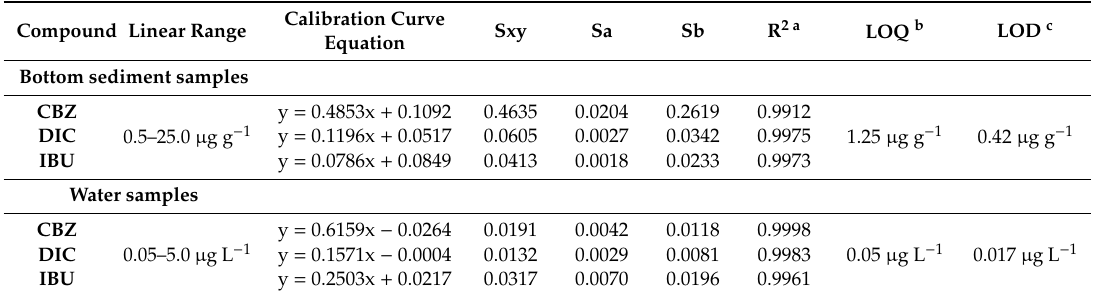
Table 2. Linear regression equations of calibration curves and calculated regression parameters ( n = 6). Compound Linear